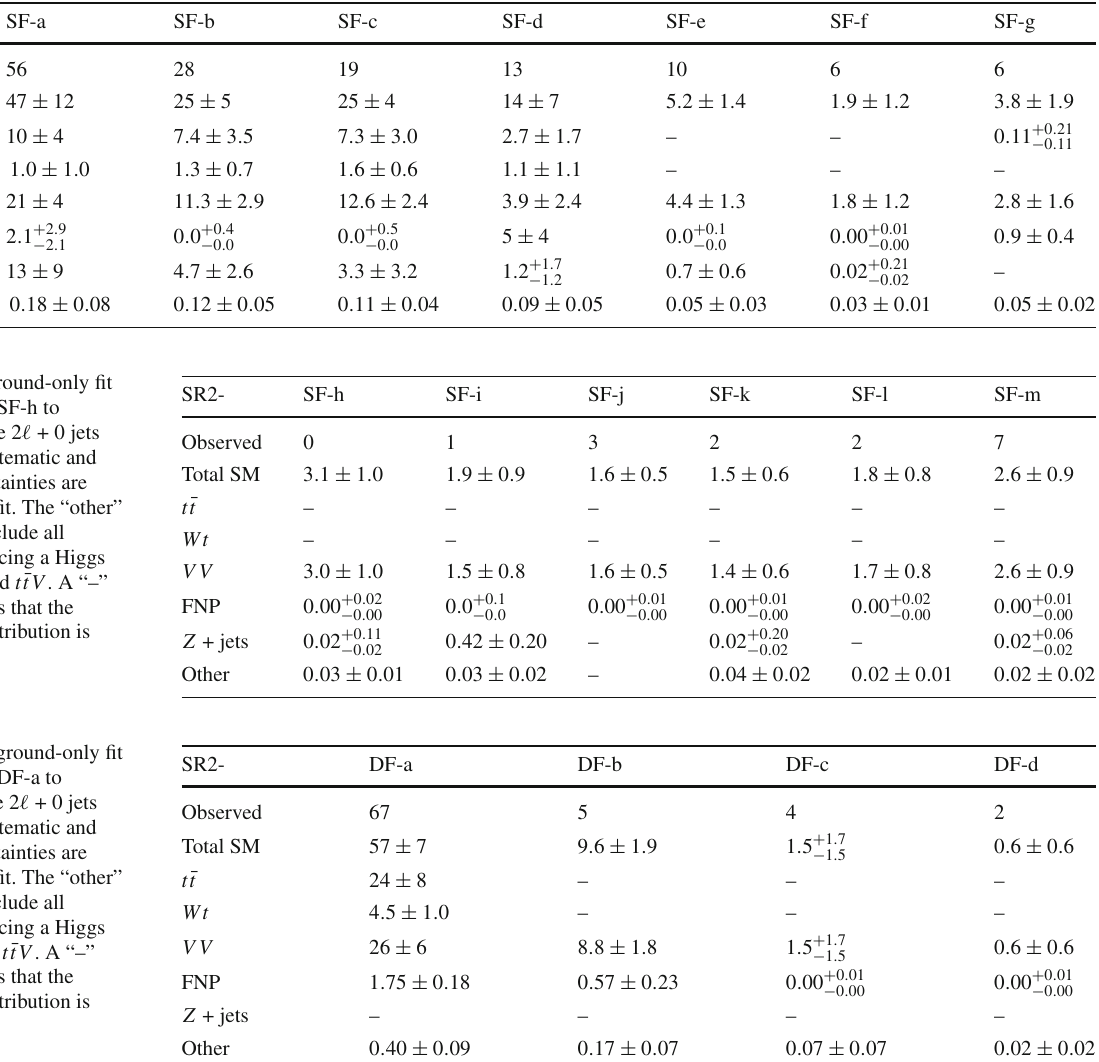
Table 8 Background-only fit results for SR2-SF-a to SR2-SF-g in the 2 (cid:4) + 0 jets channel. All systematic and statistical uncertainties are included in the fit. The “other” backgrounds include all processes pro- SR2-